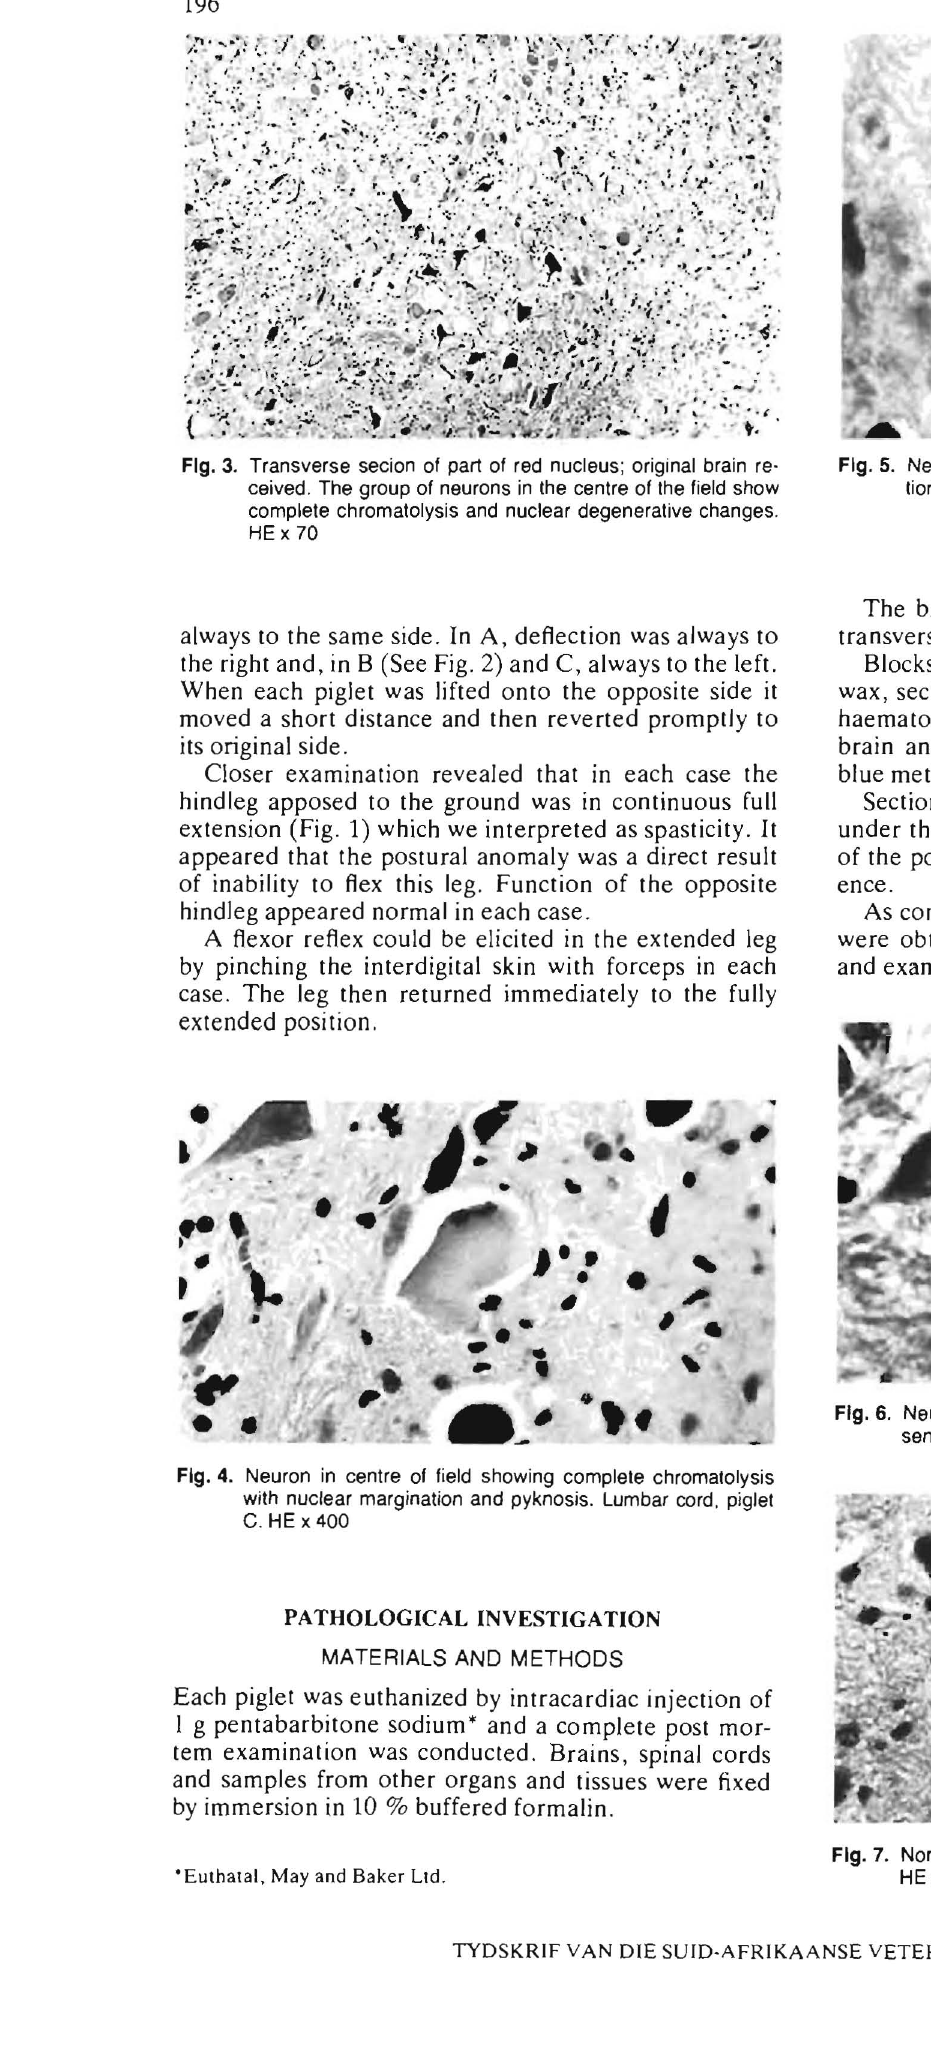
Fig. 7. Normal neurons for comparison. Lumbar cord. control piglet. HE x 400.